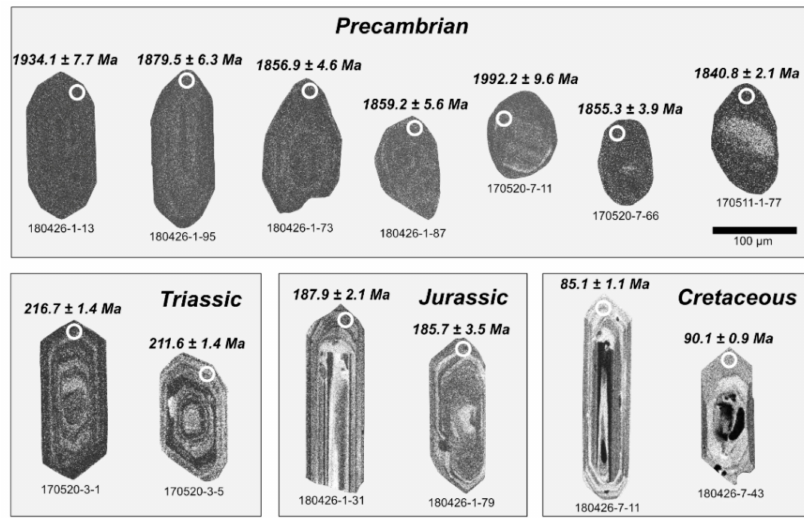
Figure 4. Scanning-electron-microscope (SEM) cathodoluminescence images of the selected zircon grains from the Neungju Basin. Mesozoic zircon grains are characterized by euhedral prismatic shapes, whereas Precambrian zircons tend to show more rounded